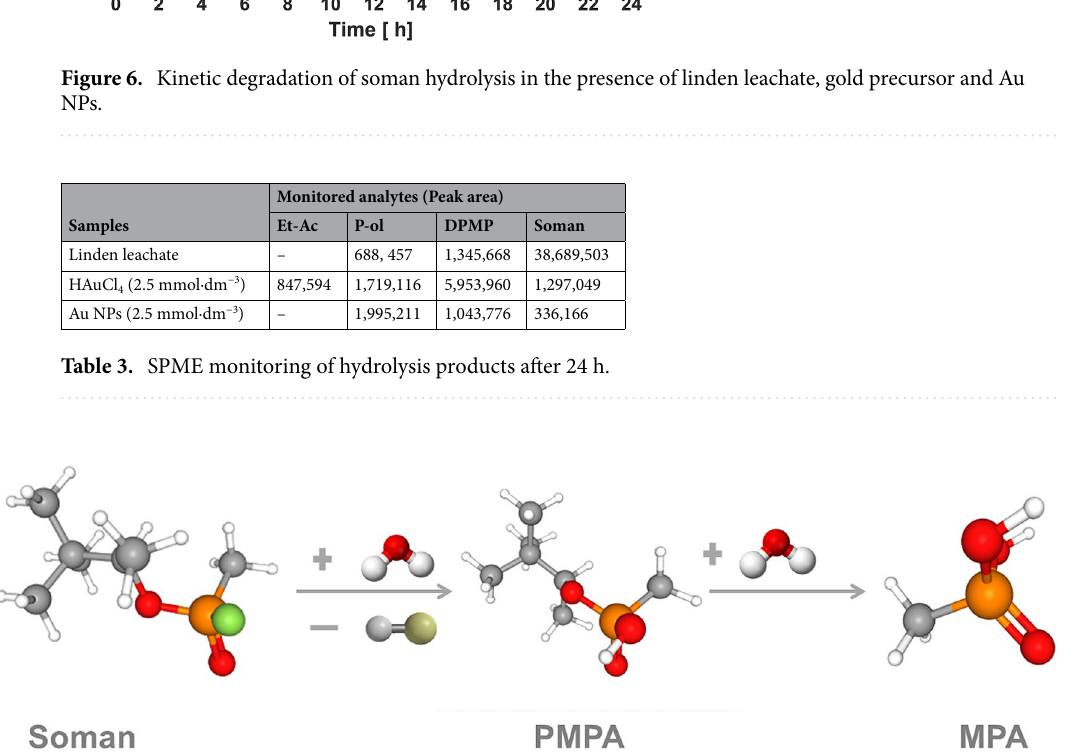
Figure 7. Hydrolysis of soman 34,35 .